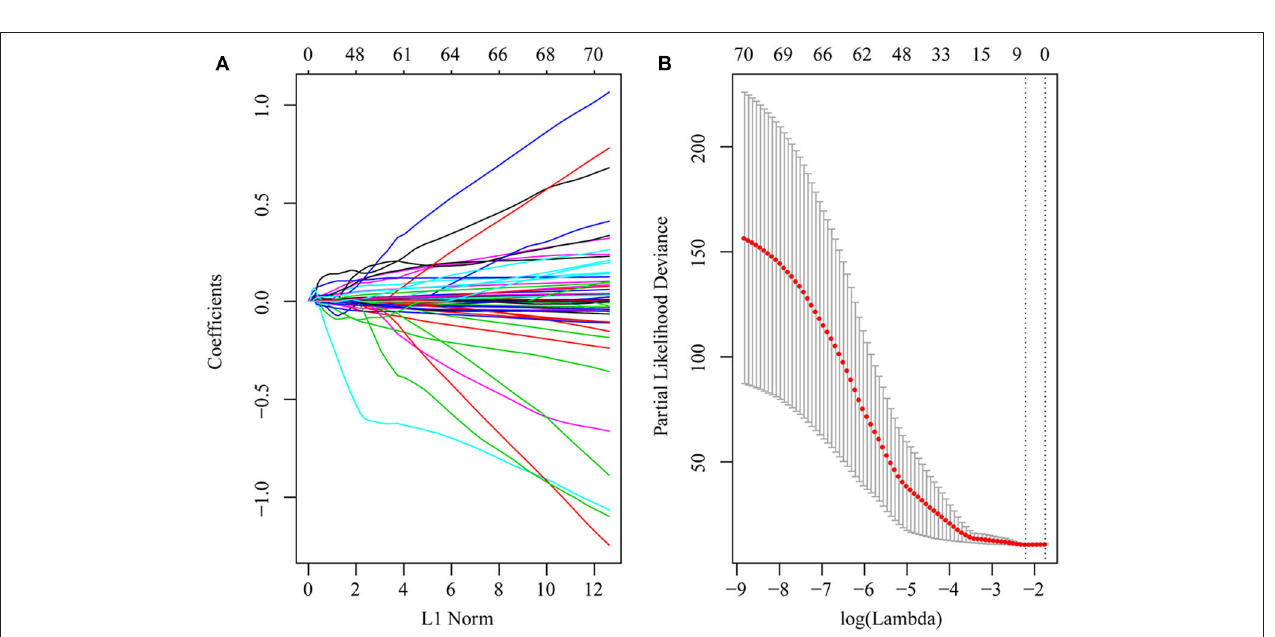
FIGURE 4 | DEGs in univariate Cox regression with P -value of < 0.01 were included in the LASSO-Cox regression model for variable compression to establish an optimal prognostic model. The model with lambda = 0.1093823 was selected as the final model. (A) LASSO-Cox regression coefficient selection and variable screening. The lower horizontal axis represents lambda value, and the upper horizontal axis scale represents the number of variables in the lasso-cox regression model, the regression coefficient (x) of which is not 0. The left vertical axis represents the value of the regression coefficient (x). (B) Cross-validation in the LASSO-Cox regression model to select the tuning parameter. The horizontal axis represents the log (lambda) value, and the vertical axis represents partial likelihood deviance. The red dots in the figure represent partial likelihood deviations ± standard error for different tuning parameters.